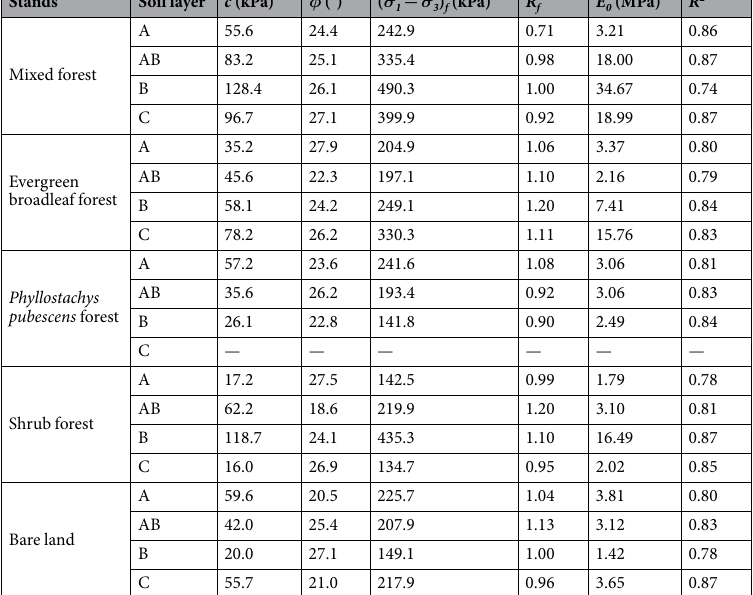
Table 1. Elastic-plastic parameters of five stand soil.